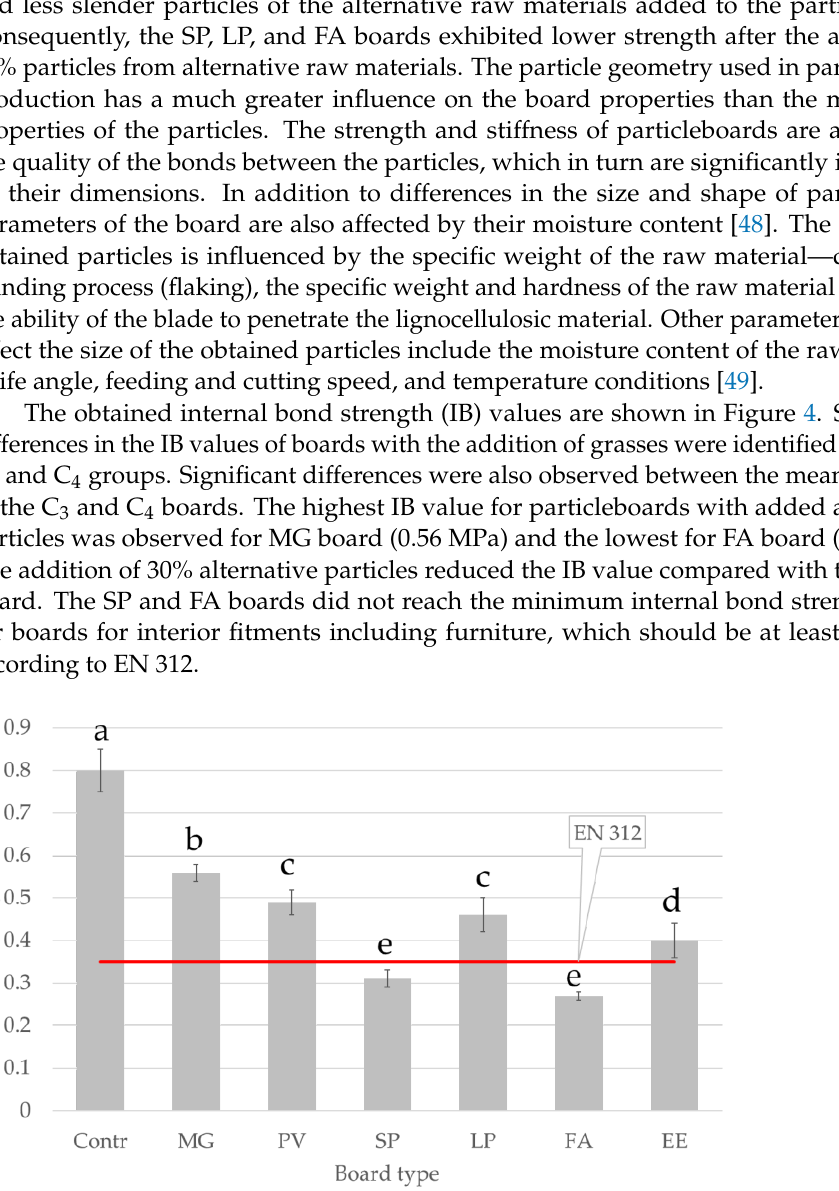
Figure 4. Internal bond strength of manufactured panels. Abbreviations used: contr.—control (100% wood); FA— Festuca arundinacea , EE— Elymus elongatus , LP— Lolium perenne , MG— Miscanthus x giganteus , PV— Panicum virgatum , SP— Spartina pectinate. Different letters indicate the presence of statistically significant differences at p < 0.05 according to one-way ANOVA and Tukey test.